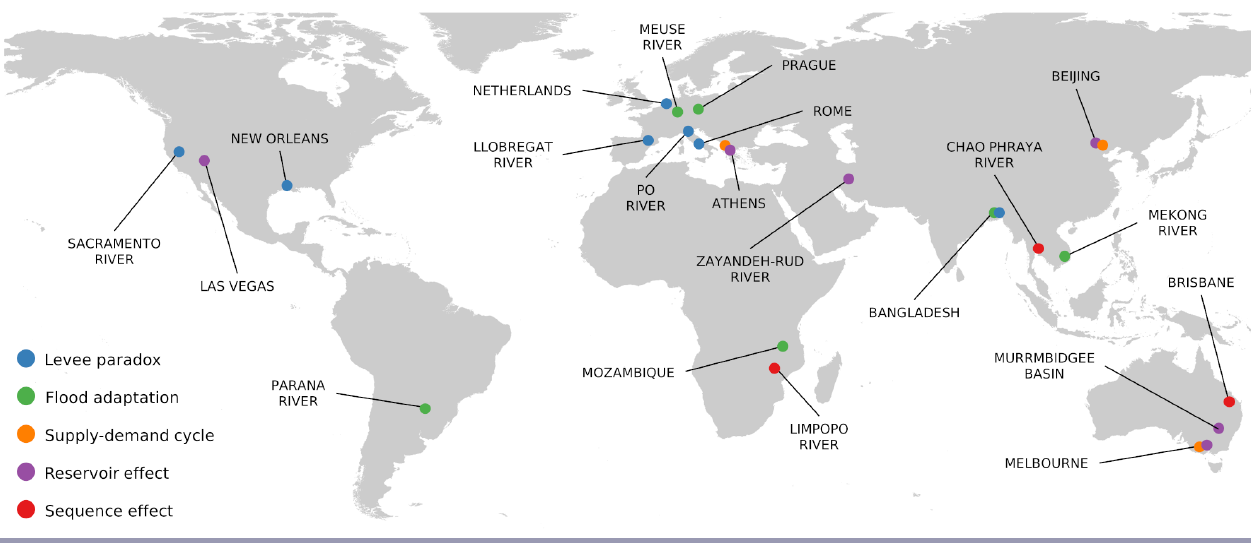
Fig. 1 . Examples of phenomena observed in various parts of the world by numerous scholars from different disciplines: levee paradox (or effect; Kates et al. 2006, Montz and Tobin 2008, Ludy and Kondolf 2012), flood adaptation (Penning-Rowsell 1996, Wind et al. 1999, IPCC 2012, Mechler and Bouwer 2014, Kreibich et al. 2017, Wens et al. 2019), supply-demand cycle (Kallis 2010, Dumont et al. 2013), reservoir effect (Gohari et al. 2013, van Dijk et al. 2013), sequence effect, i.e., flood after drought (Van den Honert and McAneney 2011, Bohensky et al. 2014, Mateo et al. 2014). Note that these authors did not necessarily use the same terms when describing these